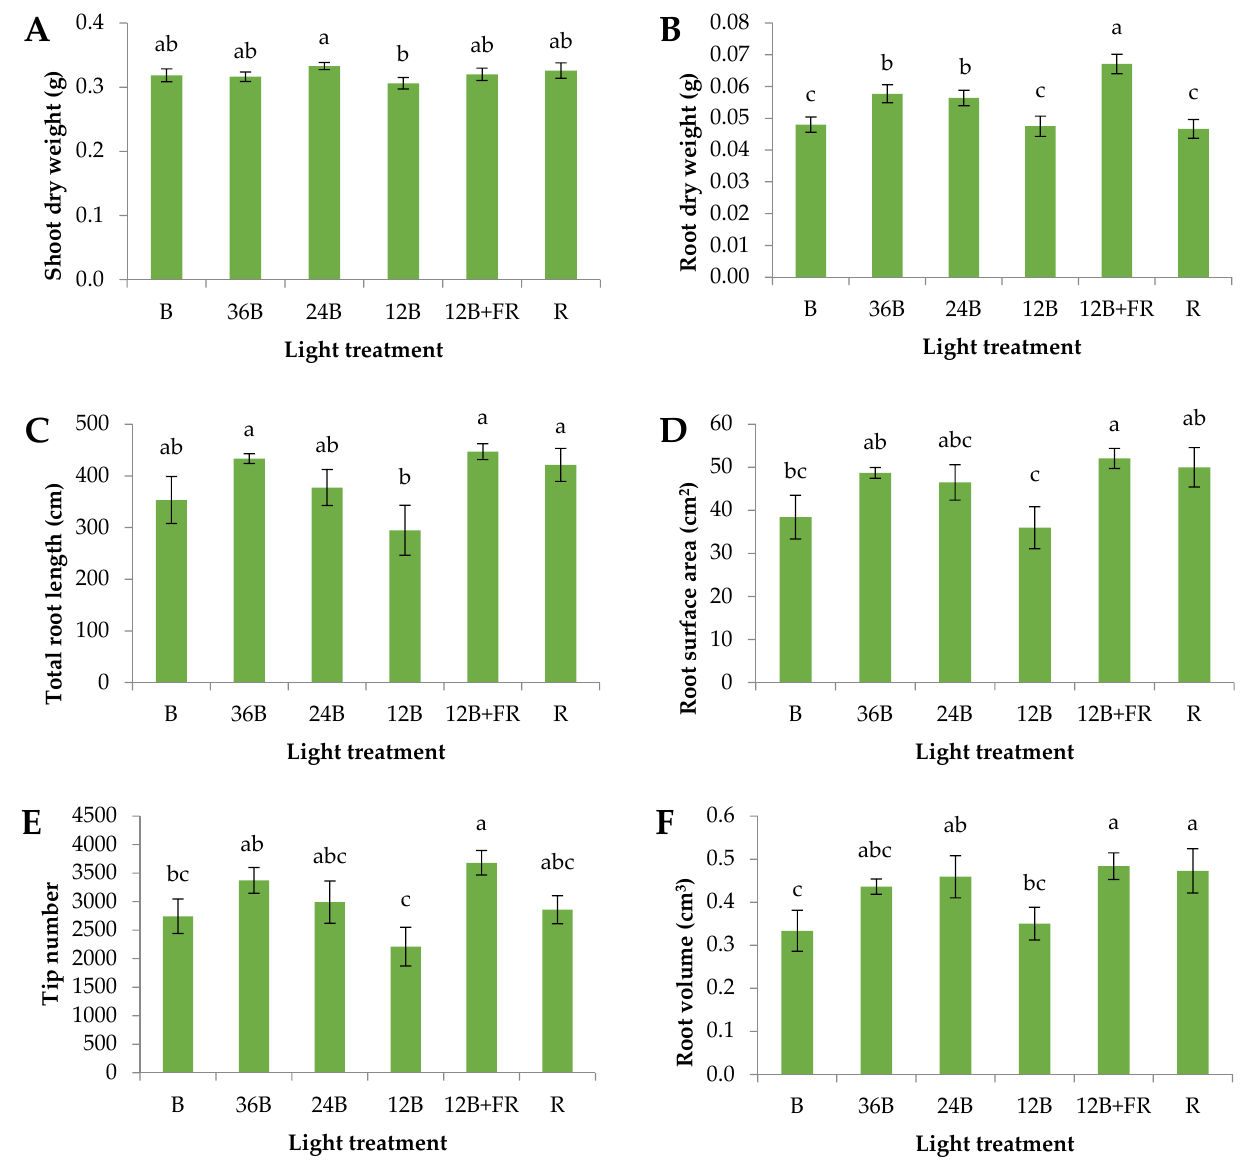
Figure 1. Grafted watermelon seedlings after healing in a chamber under six different light treat- ments for 7 days, and after acclimatization in a greenhouse for 7 days.